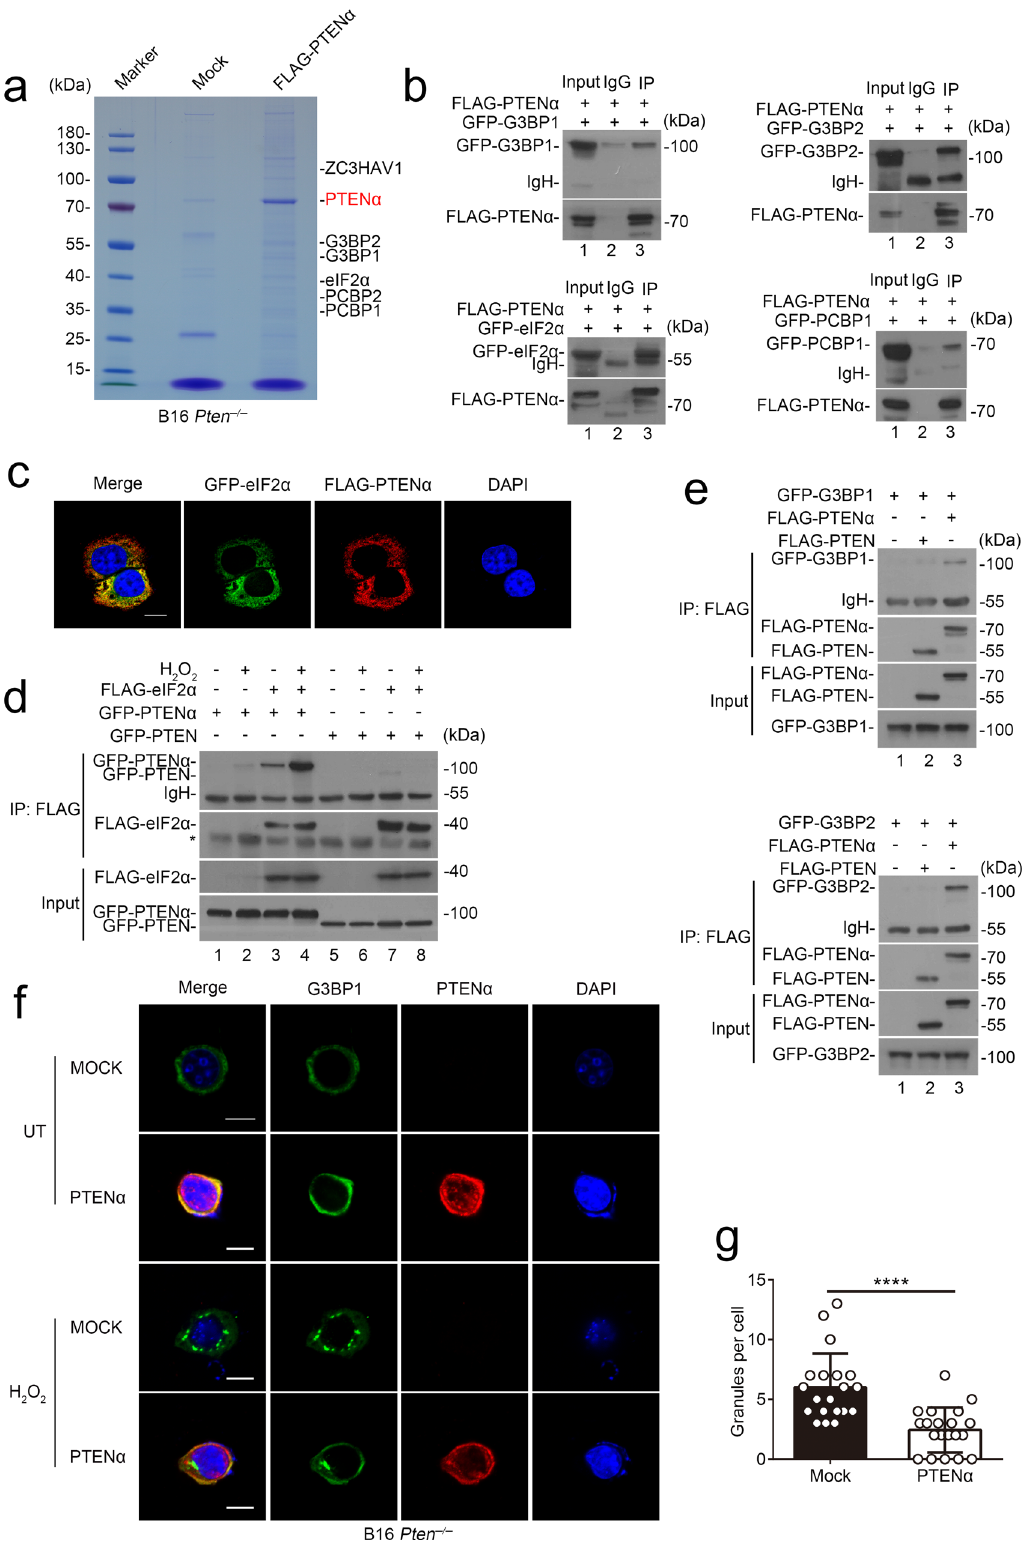
Confocal microscopy . Cells were seeded on cover glasses. 12h later, cells were fi xed with 100% acetone, permeabilized with 0.5% (vol/vol) Triton X-100 and then blocked using 1% (wt/vol) BSA dissolved in PBS. Primary antibody was applied for at least